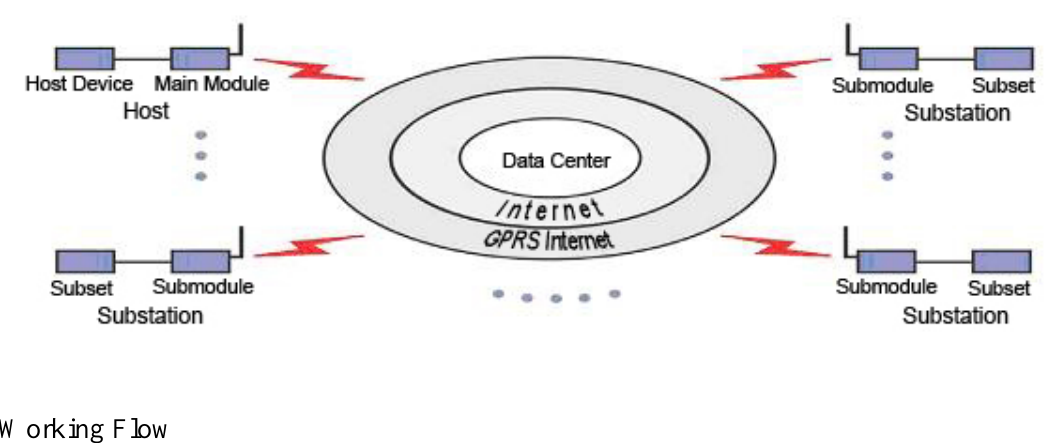
Figure 5. The communication of the GPRS/GSM